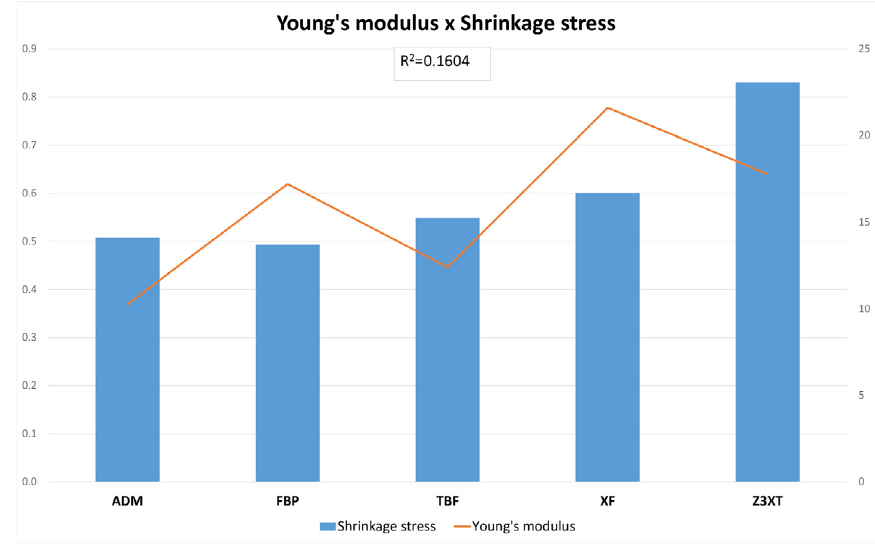
Figure 4- Young’s modulus (GPa) x Shrinkage Stress (Mpa) for high-viscosity